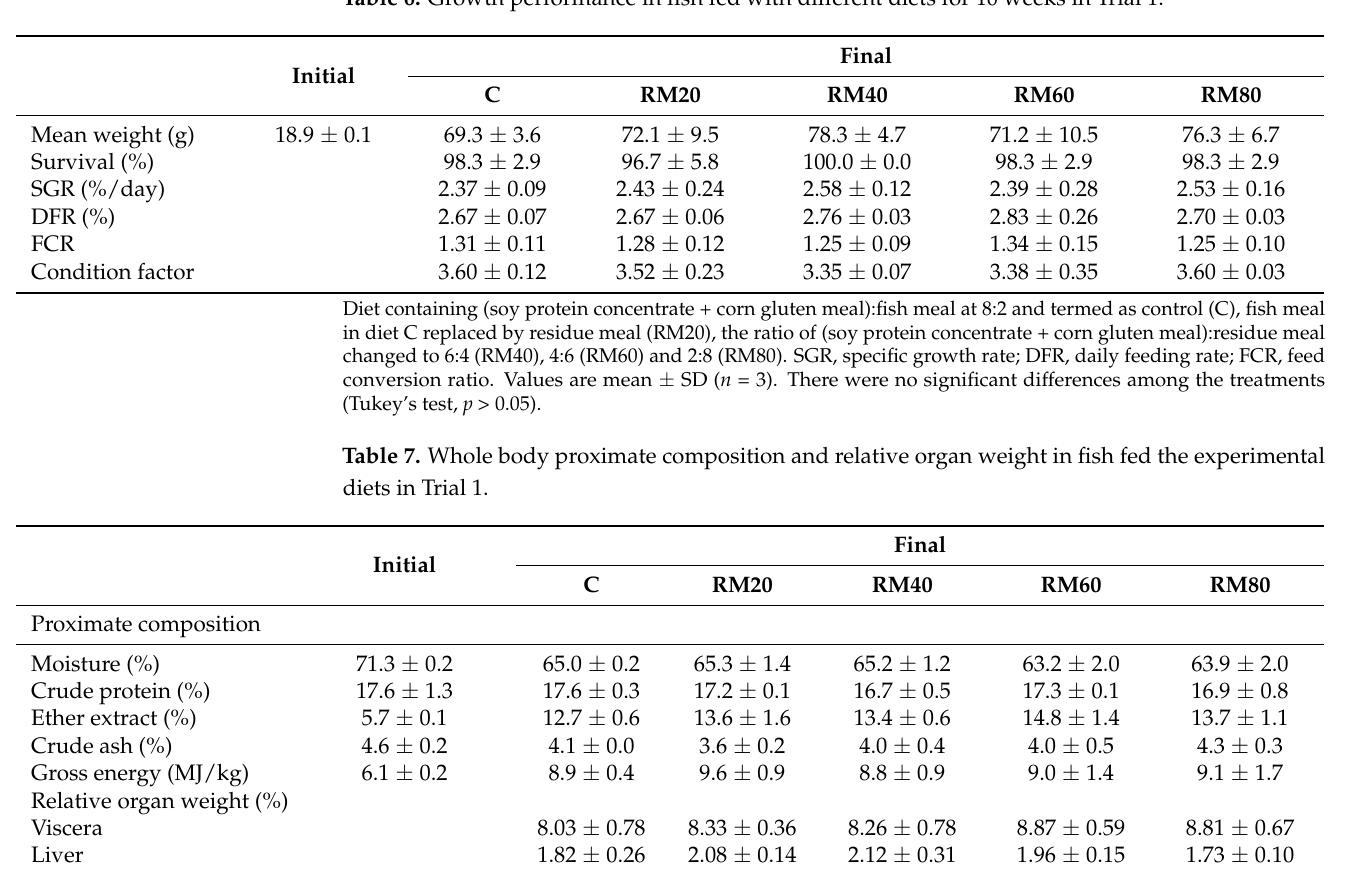
Table 6. Growth performance in fish fed with different diets for 10 weeks in Trial 1.